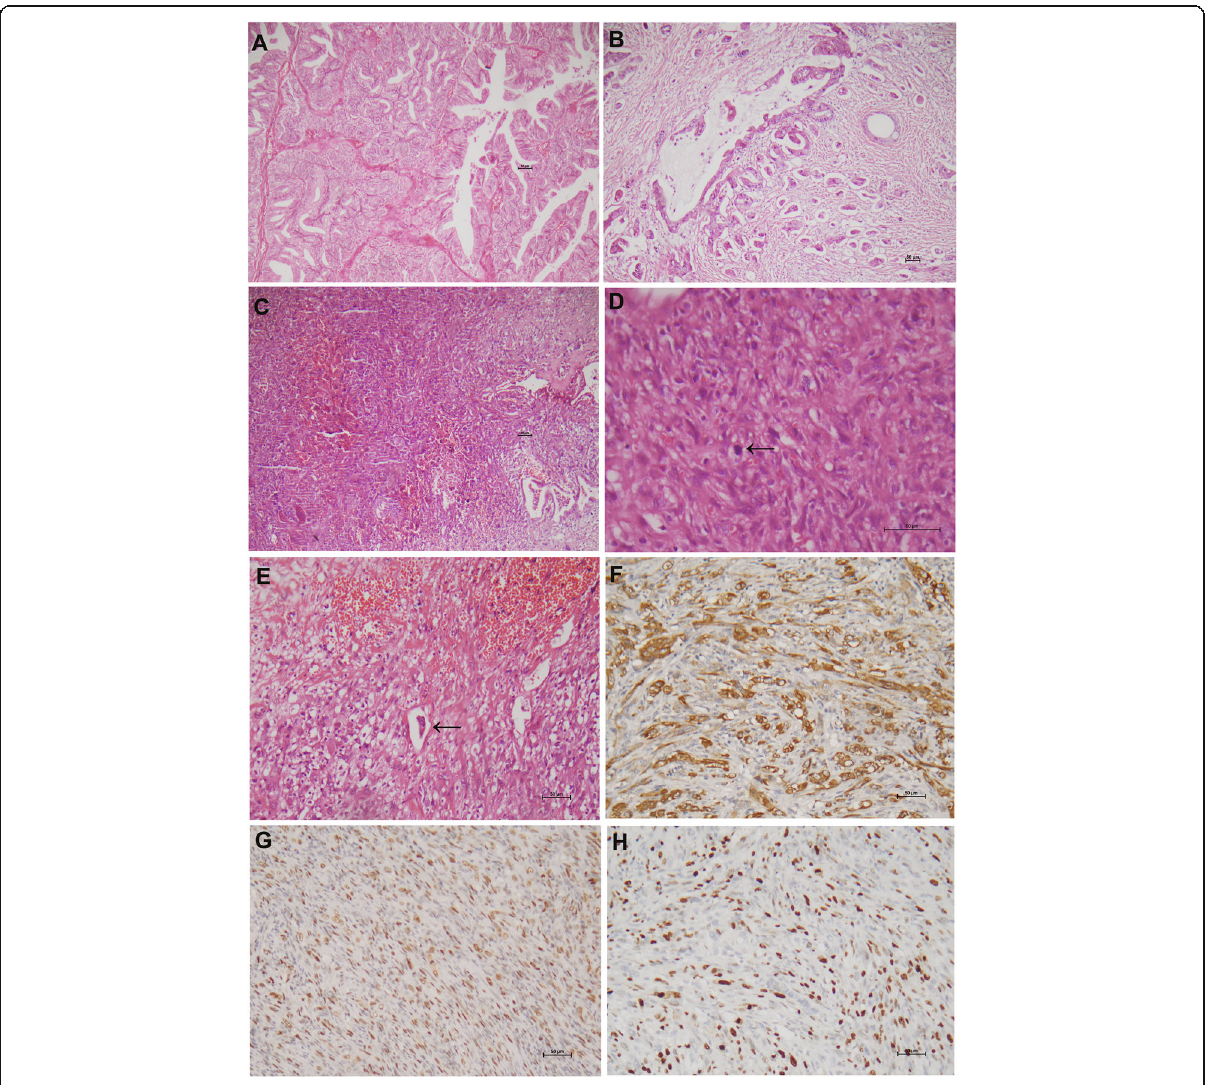
Fig. 1 Ovarian well-differentiated mucinous adenocarcinoma with mural nodules of anaplastic carcinoma (patient 1). Well differentiated mucinous carcinoma has an expansile [ a ] and destructive [ b ] invasive pattern. Depicted in c & d are the mural nodules of anaplastic carcinoma that are composed of spindled cells and polygonal cells with marked nuclear pleomorphism and active mitotic figure. [ d , arrow]. The presence of atypical glands [right lower in C] is indicative of the transitional zones of the mural nodules. Lymphovascular invasion is shown in E [arrow]. The tumor cells in the mural nodules have a strong CK [F], an aberrant p53 expression [G], and a high Ki67 index [H]. (H&E: A-C × 100, D × 400, E × 200; immunohistochemistry, F-H ×